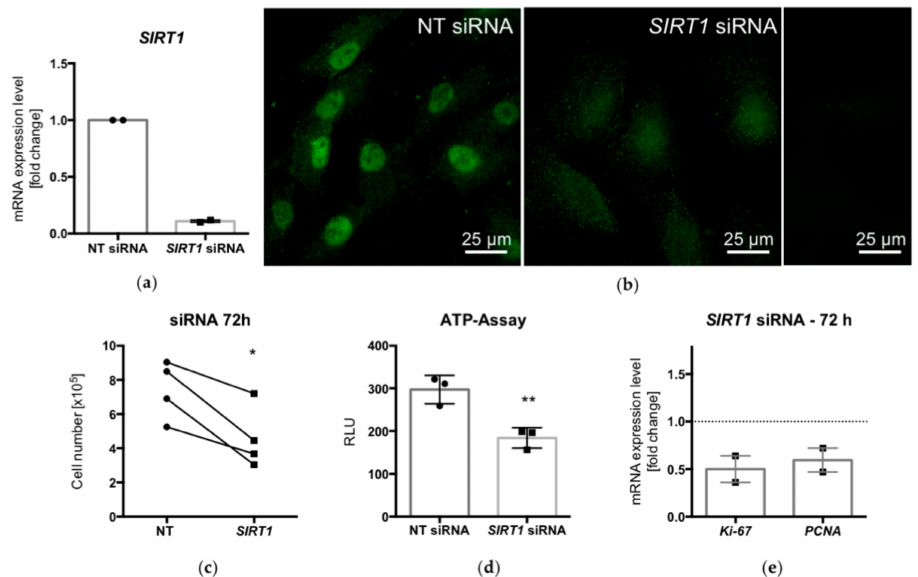
Figure 4. qPCR analysis showed decreased mRNA levels of SIRT1 after siRNA treatment for 72 h ( a ). Immunofluorescence of KGN after siRNA treatment (72 h): while in nontarget (NT) siRNA- treated cells, prominent SIRT1 staining (green) was observed mainly in the nucleus, silencing of SIRT1 strongly reduced cellular staining ( b ). Ctrl., control experiment (omission of first antibody). Cell numbers ( n = 4) and ATP levels ( n = 3) were significantly reduced after siRNA silencing ( c , d ) (* p < 0.05, ** p < 0.005, t -test). The levels of the proliferation markers Ki-67 and PCNA were decreased in SIRT1-siRNA-treated KGN, as shown by qPCR analysis ( e ) (means and SEMs; n =